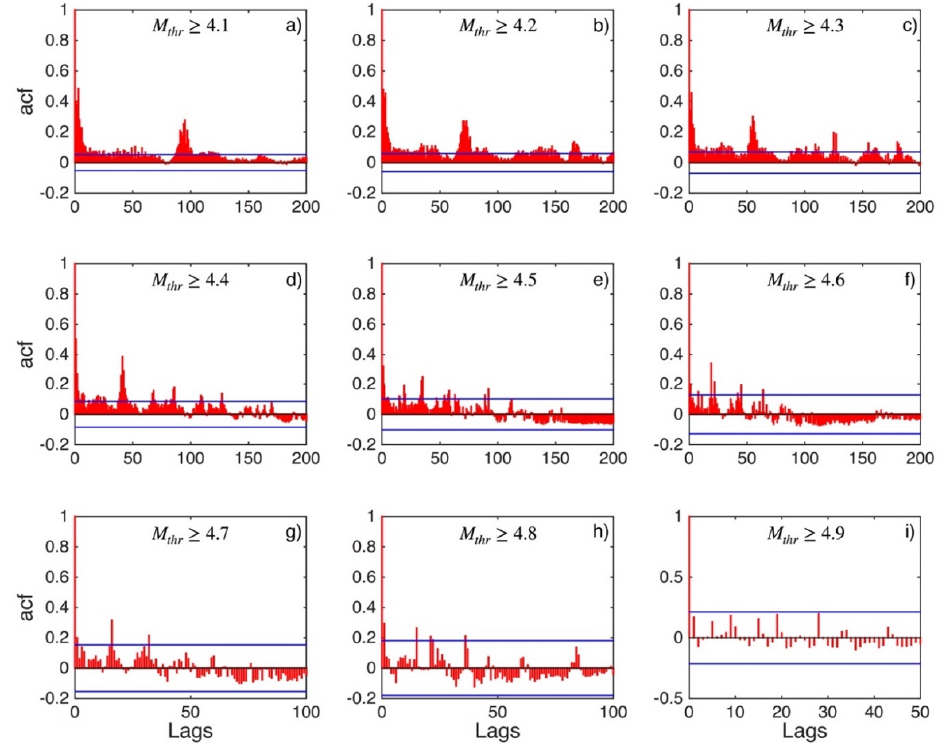
Figure 3. ACF values (red stems) and their 95% confidence intervals (blue lines) for central Ionian Islands (sub − area 2) for magnitude thresholds ( M thr ) varying from 4.1 to 4.9 (subplots a – i ).